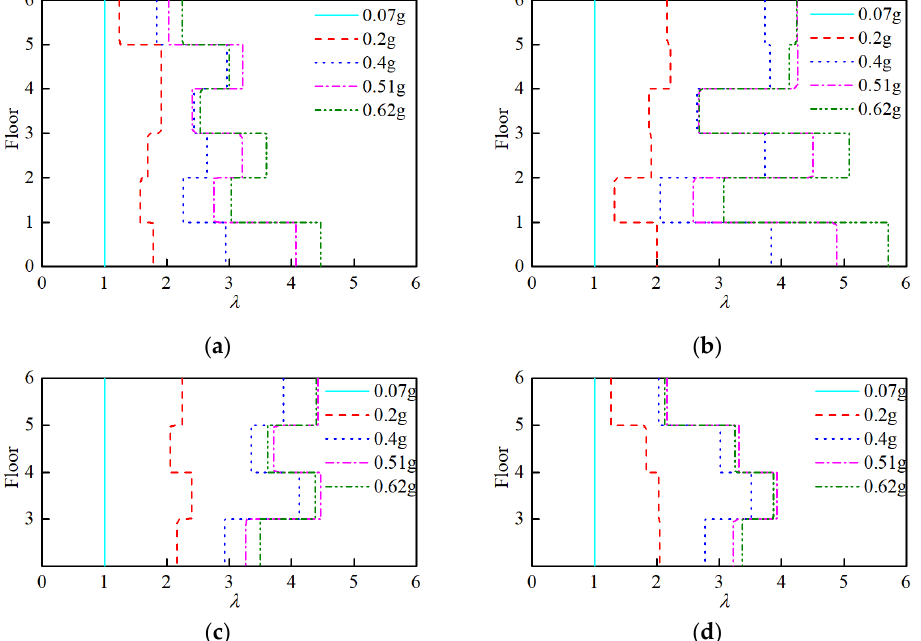
Figure 9. The 𝜆 of column along the slope direction: ( a ) Axis 1; ( b ) Axis 2; ( c ) Axis 3; ( d ) Axis 4.